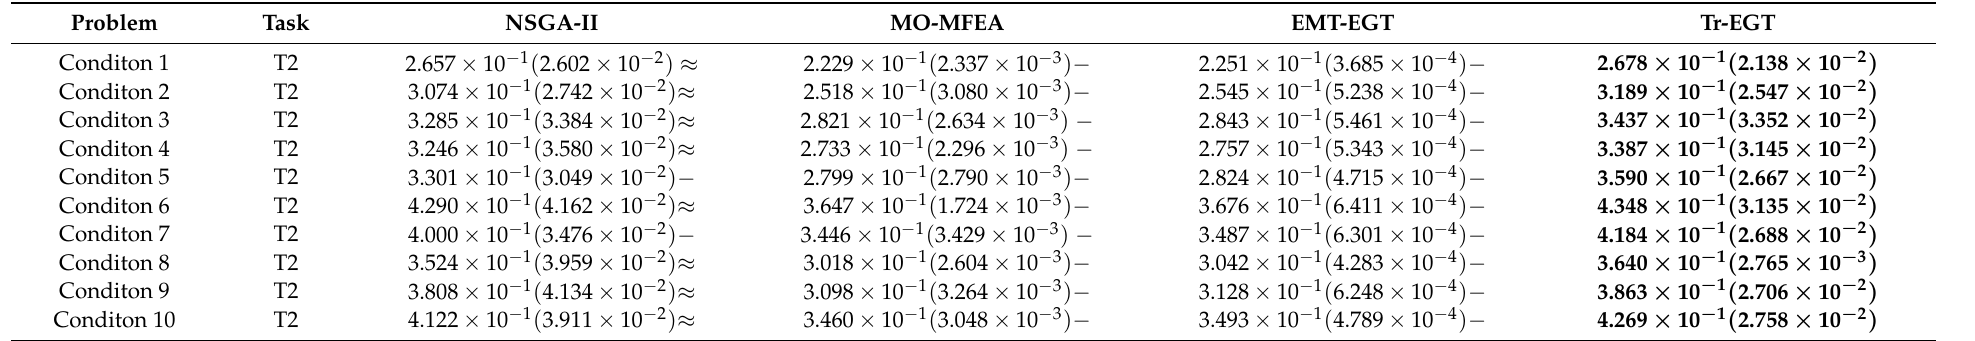
Table 7. Averaged HV value and Standard Deviation obtained by NSGA-II, MO-MFEA, EMT-EGT, and Tr-EGT of task 2 on ten